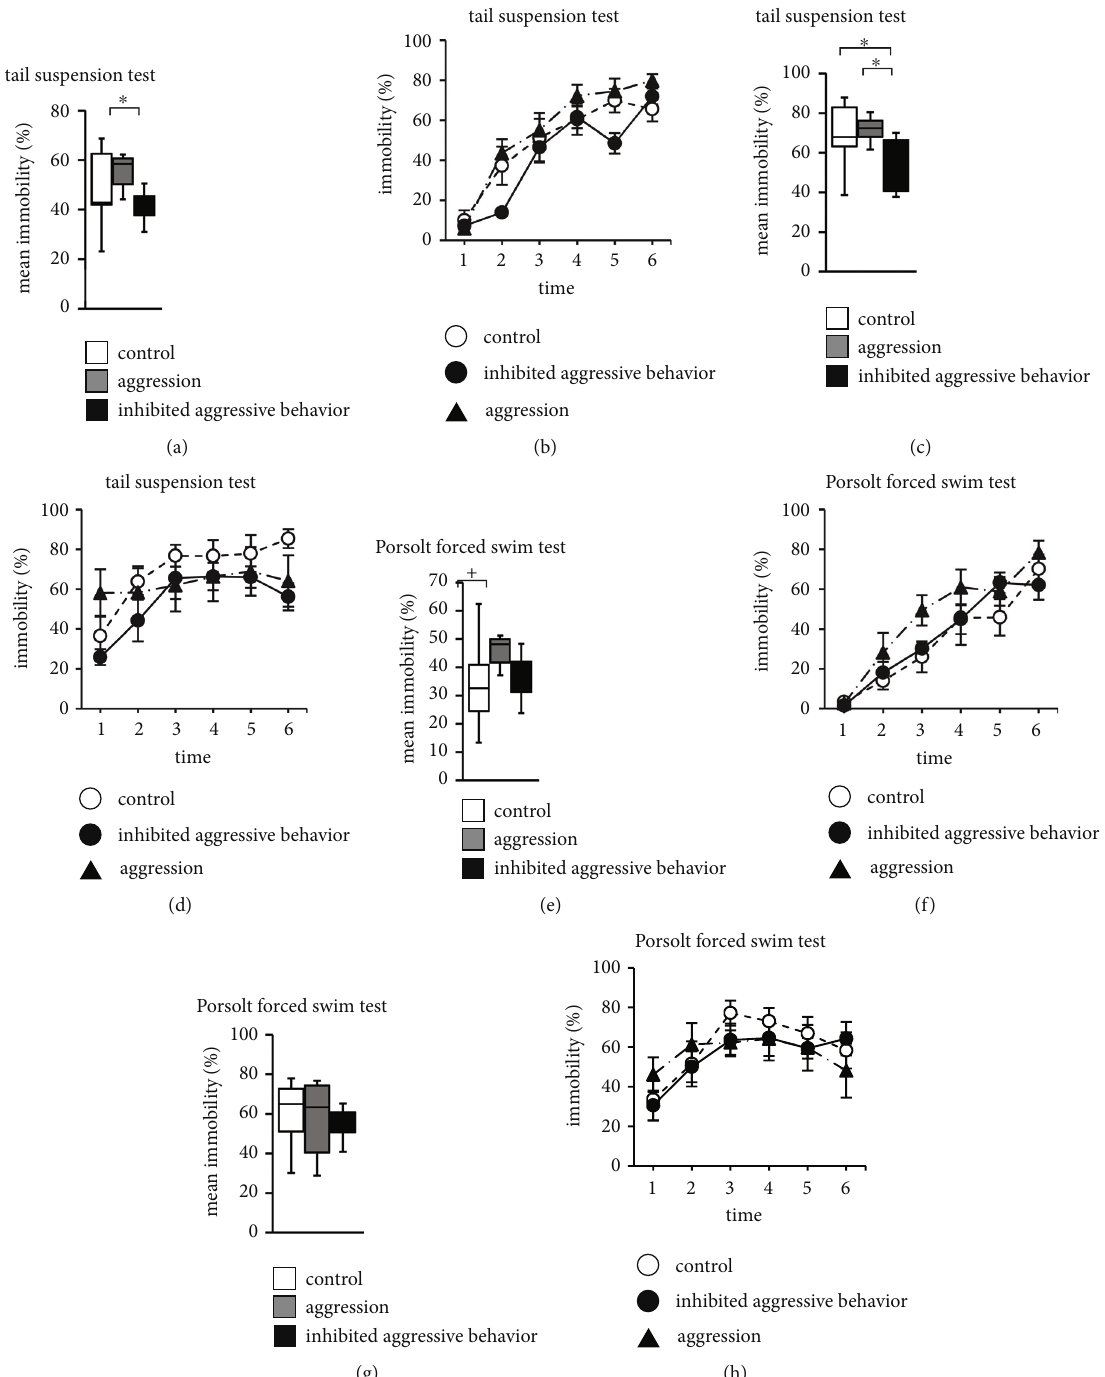
Figure 5: Performance of aggressive behavior-inhibited mice in the tail-suspension test and Porsolt forced swim test. The proportion of total time spent immobile (a), and the proportion of time spent immobile in each 1-minute period (b) on day 1. The proportion of total time spent immobile (c), and the proportion of time spent immobile in each 1-minute period (d) on day 2. The proportion of total time spent immobile (e), and the proportion of time spent immobile in each 1-minute period (f) on day 1. The proportion of total time spent immobile (g), and the proportion of time spent immobile in each 1-minute period (h) on day 2. Data are presented as box plots (a), (c), (e), and (g) or mean ± standard error (b), (d), (f), and (h). * p < 0 : 05 and + p < 0 : 1 . (a) – (h) Control group: n = 7 , aggression group: n = 7 , and inhibited aggressive behavior group: n = 7